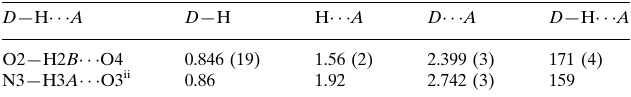
Hydrogen-bond geometry (A˚ , (cid:2)